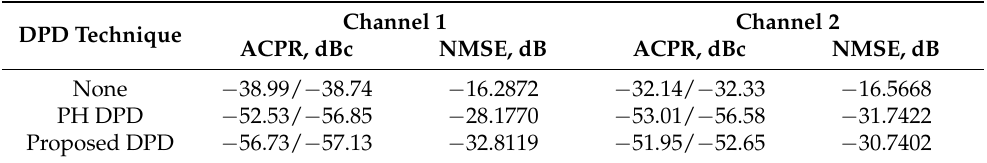
Table 1. DPD results for different models in 2 × 1 MIMO transmitters for LTE 20 MHz signal in case 1 ( K = 5, M = 2).